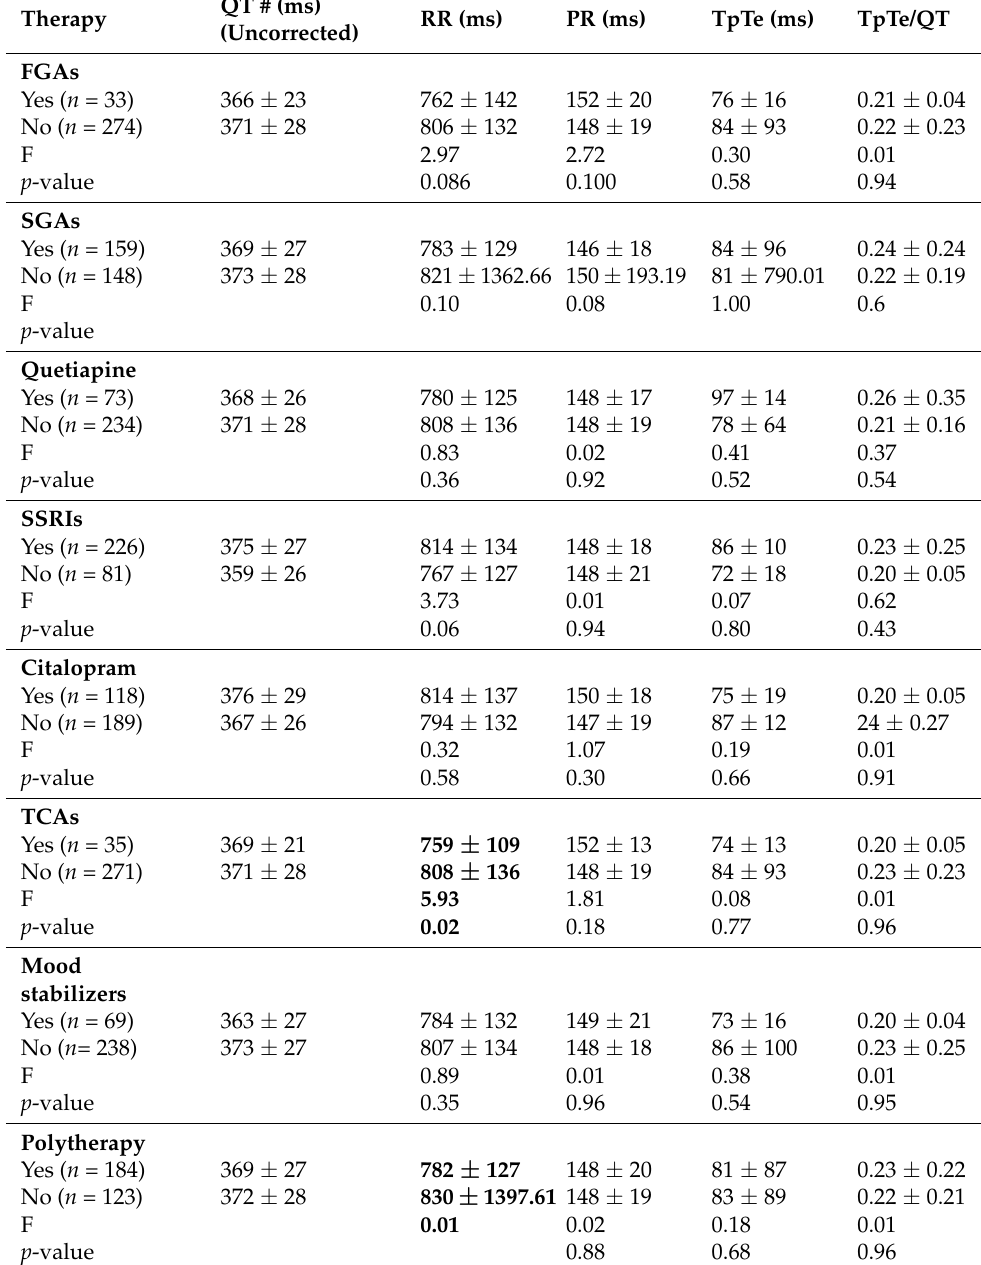
Table 3. Effect of the most commonly prescribed psychotropic therapies on RR, PR TpTe intervals and